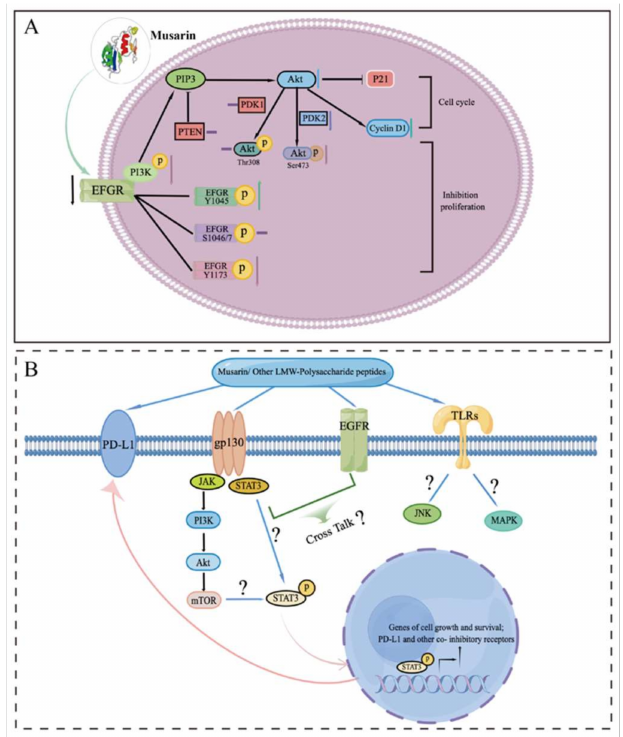
Figure 1. ( A ) Proposed molecular mechanism of Trametes versicolor -derived polysaccharide peptides’ musarin inhibitory effect on colorectal cancer. ( B ) Potential anti-proliferation molecular mechanism of musarin and other identified low molecular weight polysaccharide peptides (LMW-polysaccharide peptides) on CRC cells. (“?” Represents a mechanism that is currently unclear and need to be studied in the